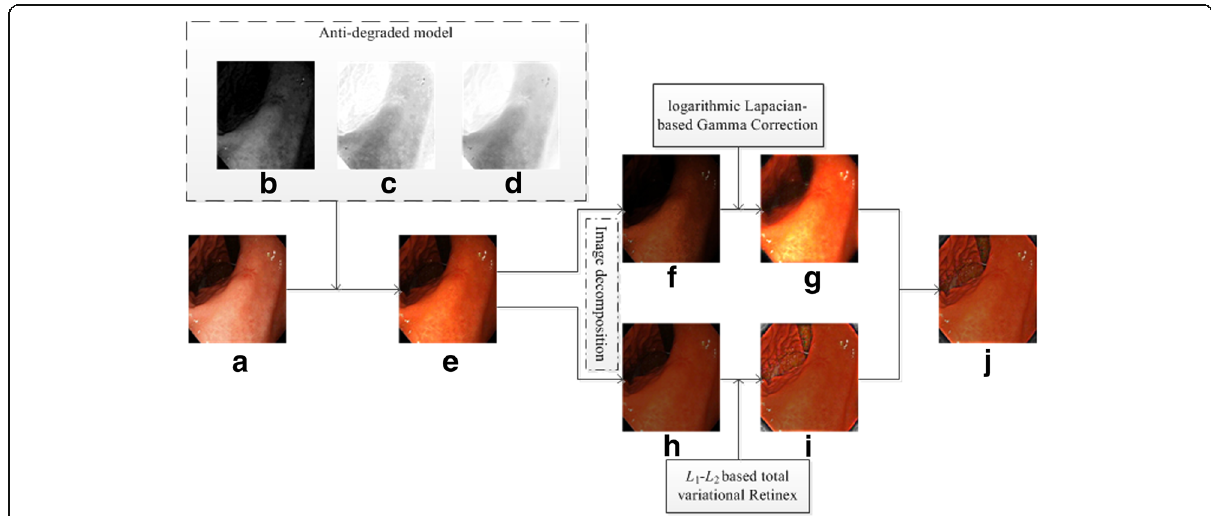
Fig. 3 Flowchart of the proposed algorithm. a Original image. b – d Dark channel, transmission map, and refined transmission map of ( a ). e Haze-free image of ( a ). f Naturalness component of ( e ). g Naturalness component with gamma correction. h Detail component of ( e ). i Reflectance component of ( h ). j Output